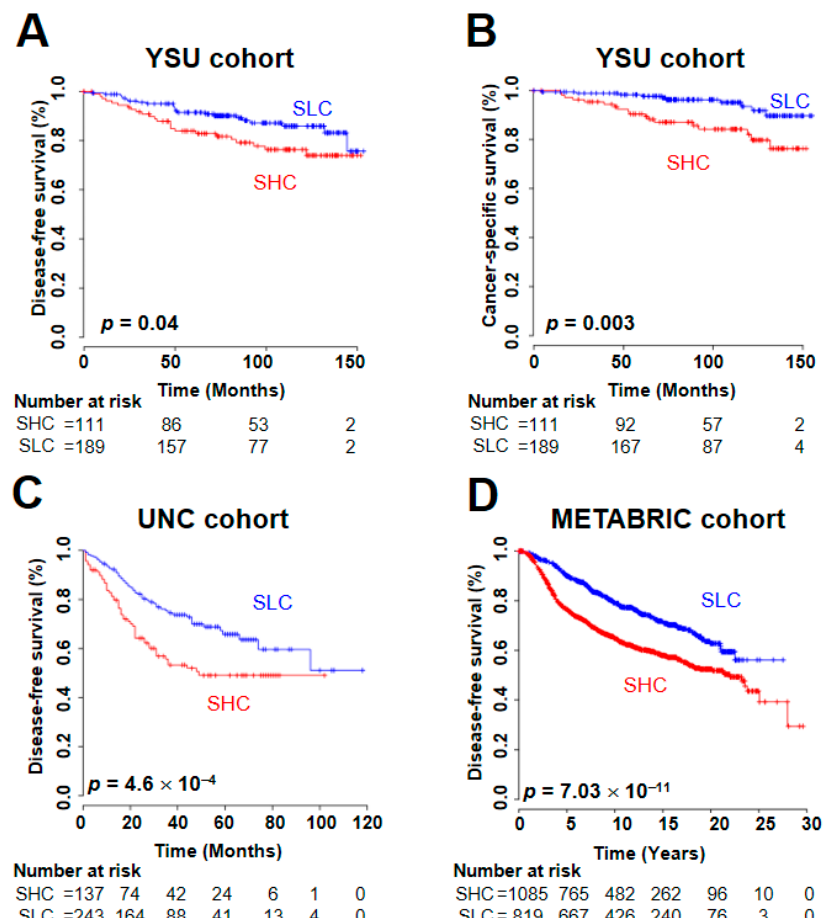
Figure 2. Prognosis of two subgroups dichotomized by the standardized uptake value (SUV) signature in the multiple breast cancer (BRC) patient cohorts. By a hierarchical clustering analysis of the SUV-associated genes, the BRC samples were divided into two groups: an SUV-high cluster (SHC) and an SUV-low cluster (SLC) (Figure S4). The survival rate of BRC patients in each subgroup was estimated. ( A ) In the YSU cohort, the disease-free survival (DFS) rate in the SHC was significantly lower than in the SLC (log-rank test; p = 0.043). ( B ) The cancer-specific survival rate in the SHC was also significantly lower than that in the SLC in the YSU cohort (log-rank test; p = 0.003). ( C ) When patients in the UNC cohort were divided into the SHC and SLC by hierarchical clustering using genes in the SUV signature, the DFS rate in the SHC was significantly lower than that in the SLC (log-rank test; p = 4.6 × 10 − 4 ). ( D ) When the same procedure was applied to the METABRIC cohort, the SUV signature showed statistical significance for predicting BRC DFS (log-rank test; p = 7.03 × 10 − 11 ).